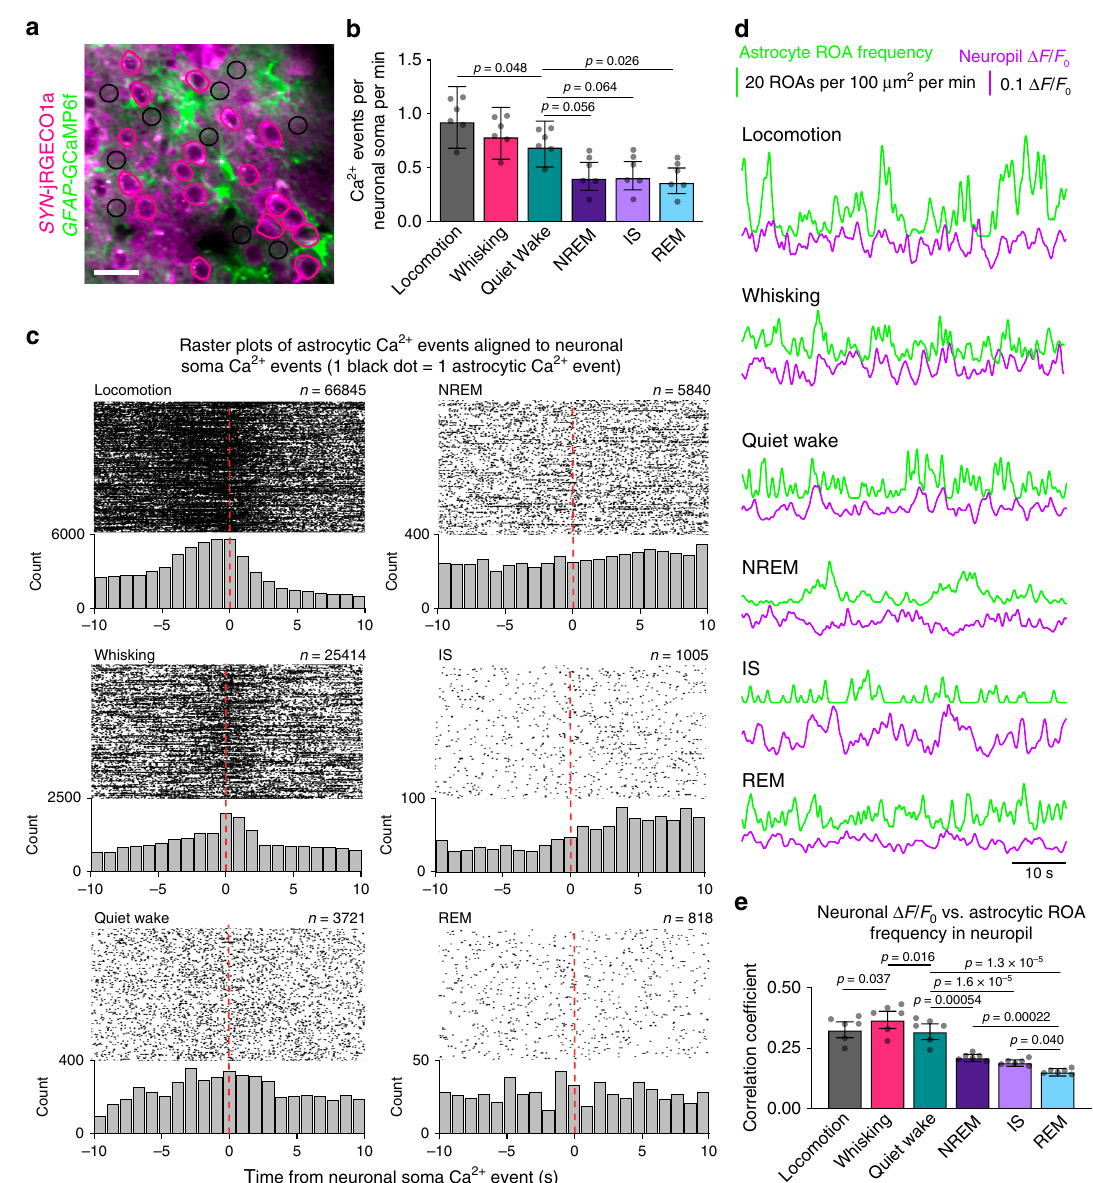
Fig. 6 Correlation of astrocytic and neuronal Ca 2 + signals. a Representative image of SYN -jRGECO1a fl uorescence in neurons and GFAP -GCaMP6f fl uorescence in astrocytes, and ROIs over neuron somata (pink) and neuropil (black circles of 10 μ m in diameter). ROIs were manually segmented in 92 time series from 6 mice. Scale bar 20 μ m. b Frequency of Ca 2 + signals in neuron somata across sleep-wake states . Data represented as estimates ± SE, and p -values (two-sided test, no adjustment for multiple comparisons) derived from linear mixed effects models statistics, n = 6 mice, 92 trials. c Raster plots and histograms (1 s bins) of the onset time difference for astrocytic Ca 2 + events in neuropil ROIs (black circular ROIs in a ) relative to a Ca 2 + event in neuron somata ROIs (pink ROIs over neuron somata in a ). Each black dot represents the temporal location of one astrocytic Ca 2 + event relative to a Ca 2 + event in a neuronal soma. d Example traces of continuous astrocytic Ca 2 + event frequency in neuropil ROIs (number of ROAs per 100 μ m 2 per minute), and neuronal Ca 2 + signal Δ F / F 0 in neuropil ROIs during locomotion, whisking, quiet wakefulness, NREM sleep, IS sleep, and REM sleep. e Correlation coef fi cient between continuous traces of astrocytic Ca 2 + event frequency in neuropil, measured as number of ROAs per 100 μ m 2 per minute, and neuronal Ca 2 + signal Δ F / F 0 in neuropil across sleep-wake states. Data represented as estimates± SE and p -values (two-sided test, no adjustment for multiple comparisons) derived from linear mixed effects models statistics, n = 6 mice, 81 trials. For details on statistical analyses, see “ Methods ”